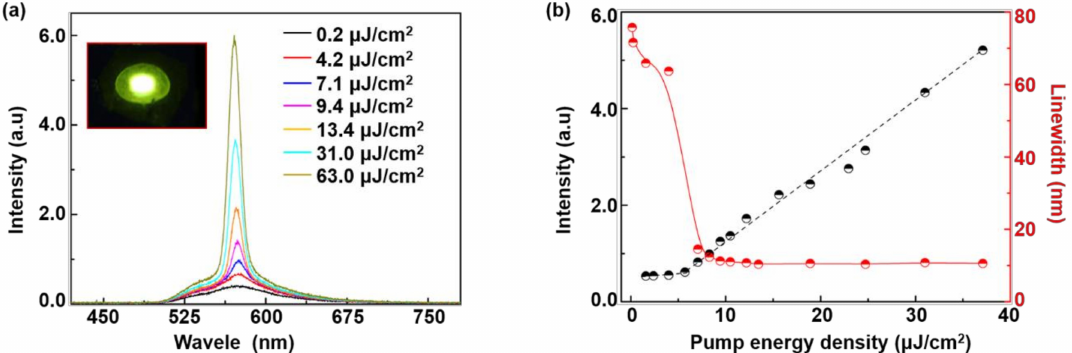
Figure 4. ( a ) Emission spectra of the random laser with di ff erent pump energy densities. Inset: photograph of the operating random laser. ( b ) Emission intensities (black dots) and the linewidth (red dots) as a function of the pump energy